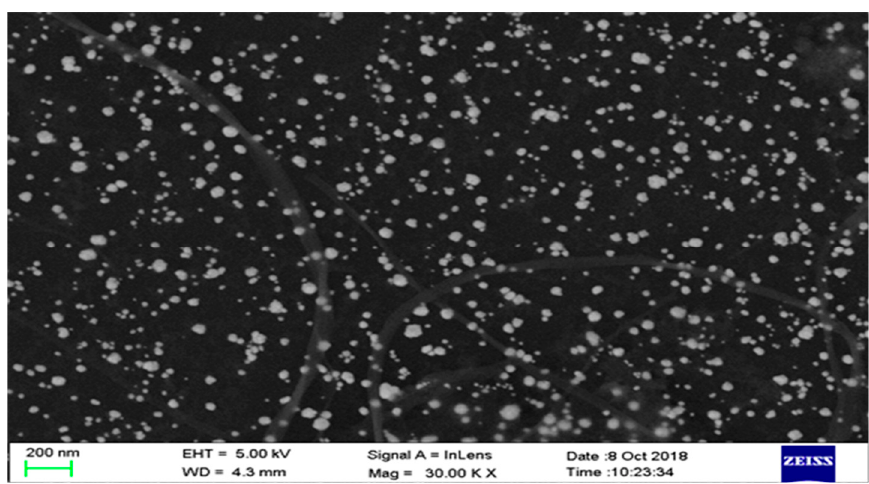
Figure 2. Field emission scanning electron microscopy image of Au NPs-TH-CG on GCE.